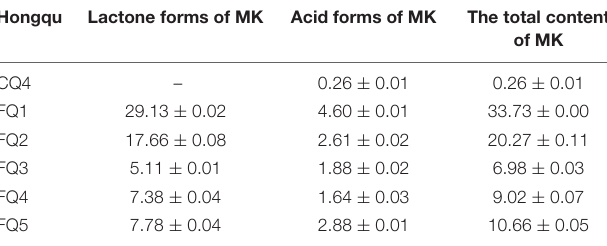
Frontiers in Microbiology |